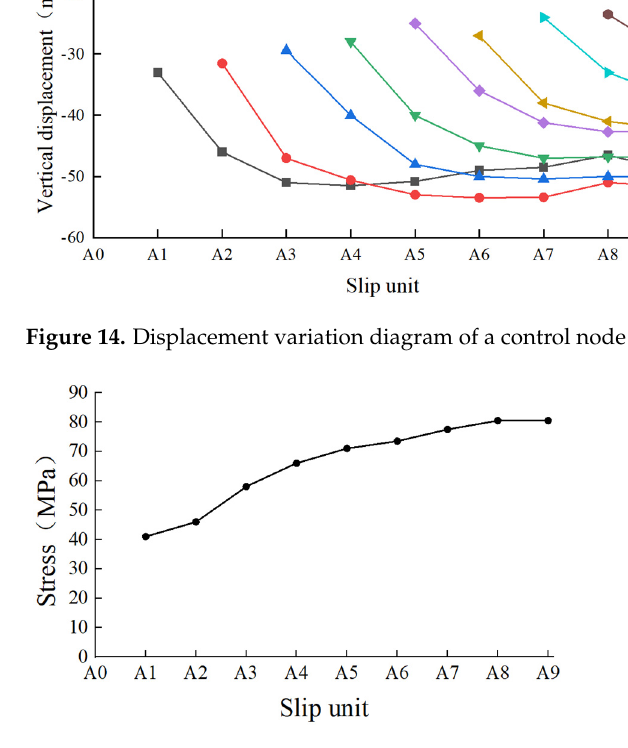
Figure 15. Stress change curve of the first unit control bar.